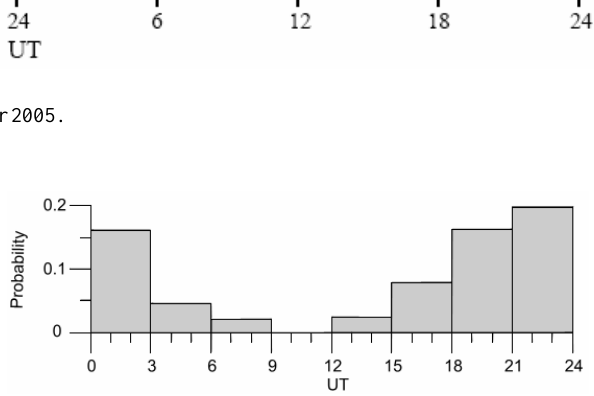
Fig. 3. The probability of observing the spectral resonant structures as a function of Universal Time revealed from the search coil mag- netometer measurements in Barentsburg during